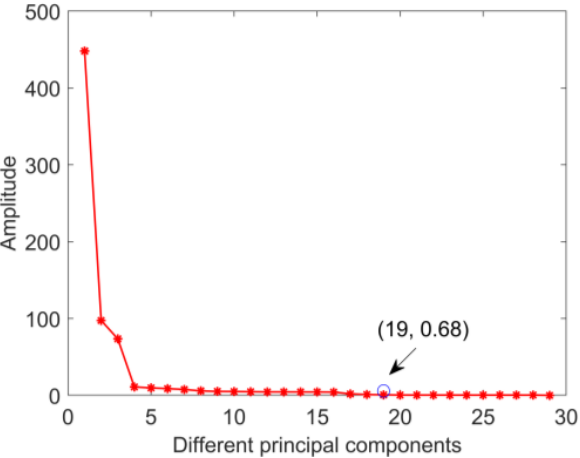
Figure 7. Amplitude of quality factor in different principal components.